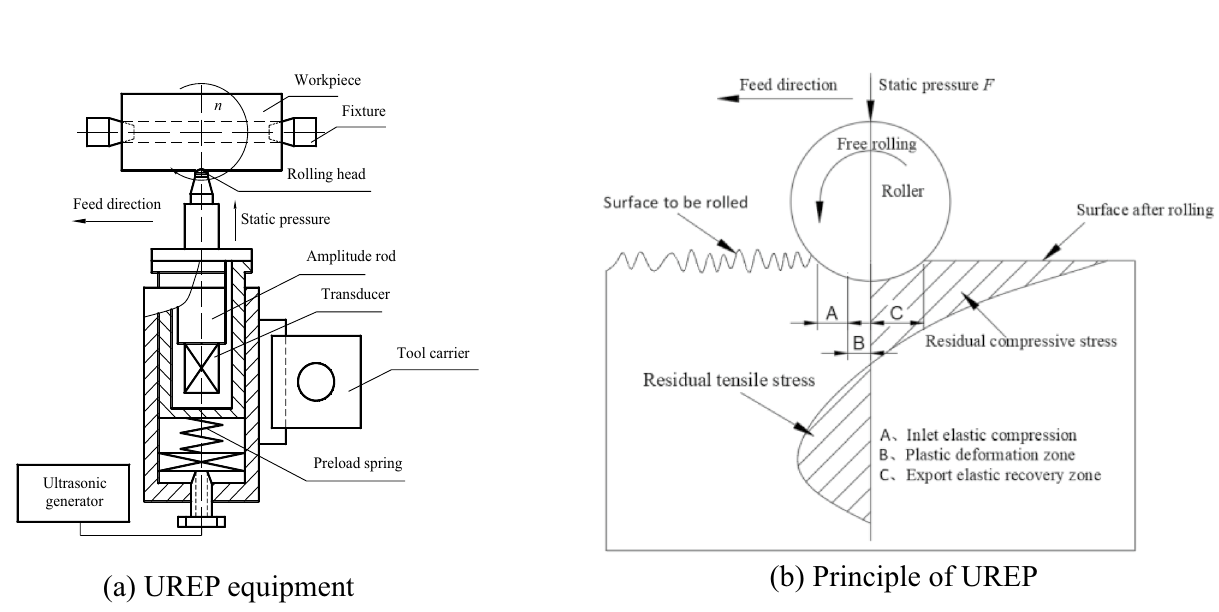
Figure 3. UREP machining